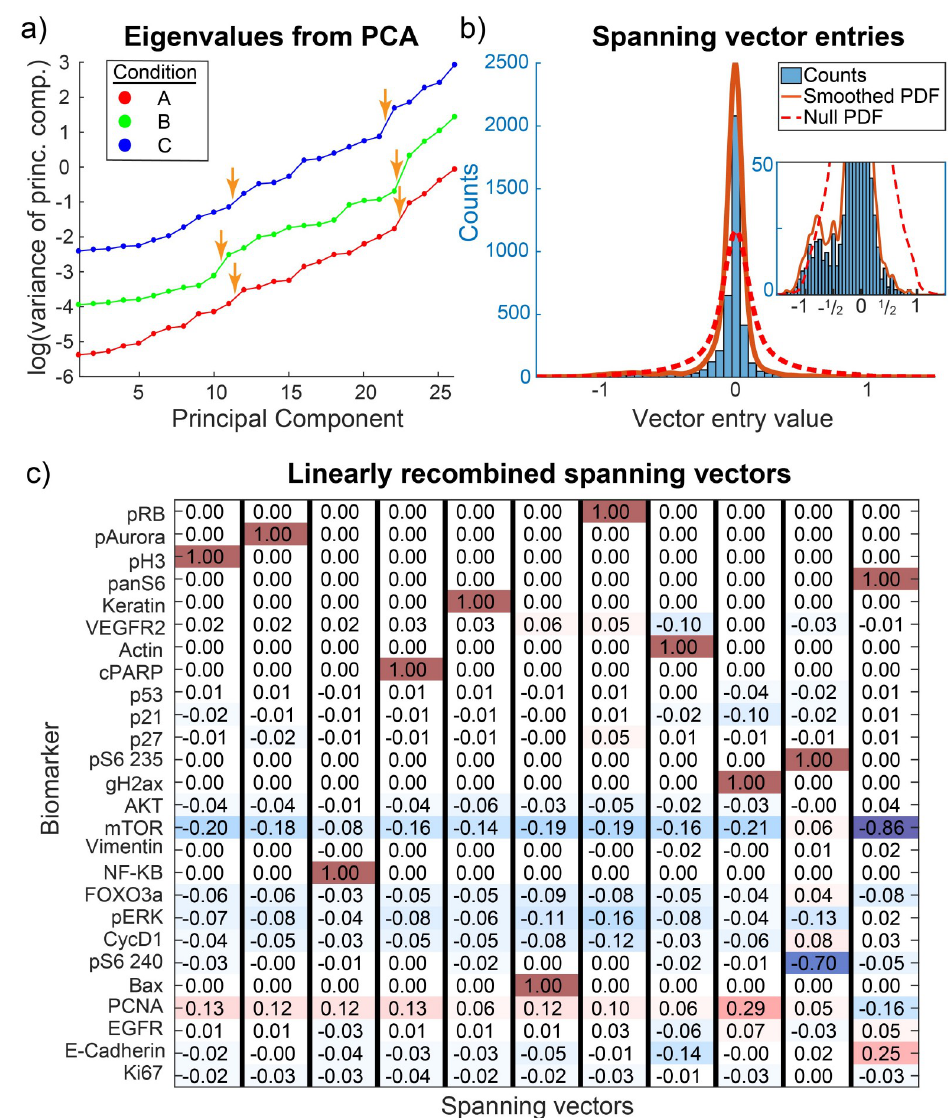
Fig 5. Peculiar properties of single-cell high-dimensional datasets (CyCIF). (a) The dominant subpopulations of the MCF10A cells were analyzed by PCA and the eigenvalue spectra are shown for 3 of the 24 conditions (shifted to avoid overlap). Some, but not all, apparent gaps denoted by orange arrows. (b) Singular eigenvectors were linearly recombined by row reduction on their transpose, with complete pivoting. The distribution of entries is displayed, along with a null. (c) Condition A’s dominant subpopulation’s recombined, singular eigenvectors are shown. Net reactions link the various proteins, such as S6 with mTor, or the two phosphoforms of S6 (235 and 240). Other conditions show similar